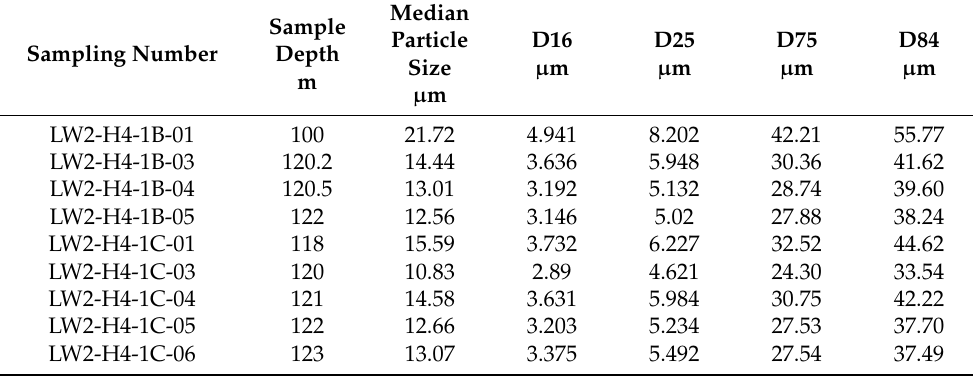
Table 2. Particle size distribution of rock samples from cruise